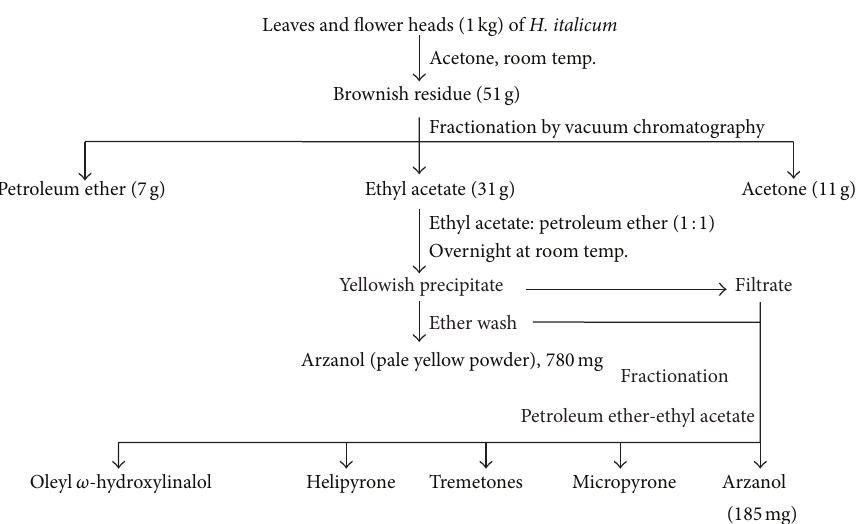
Figure 1: Schematic representation of isolation of phytochemical constituents of H. italicum subsp. microphyllum . (Adapted and modified from Appendino et al.